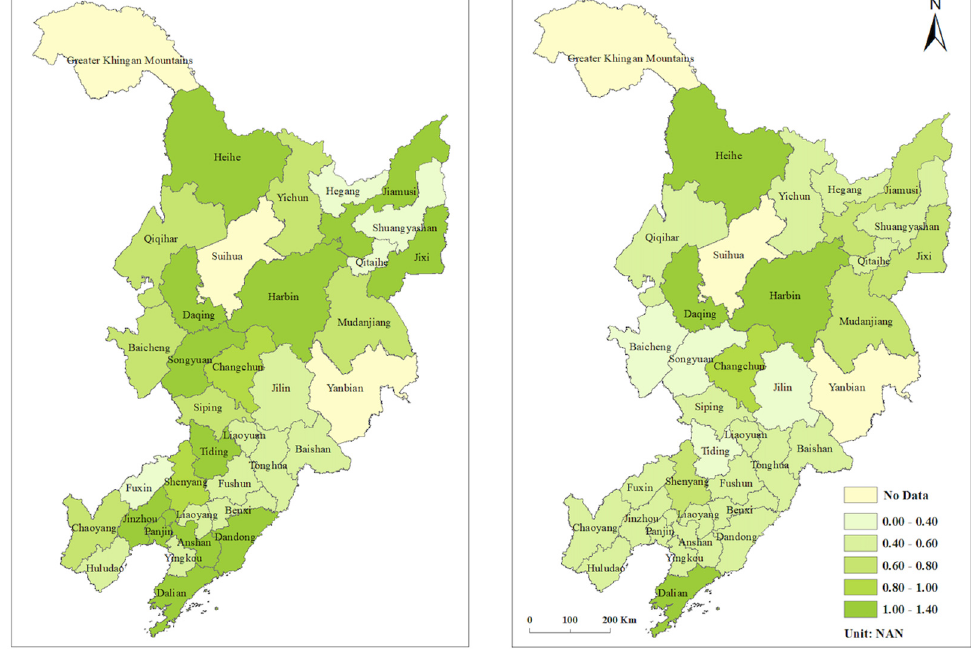
Figure 2. Carbon dioxide (CO 2 ) emission efficiency of prefecture–level cities in northeast China.